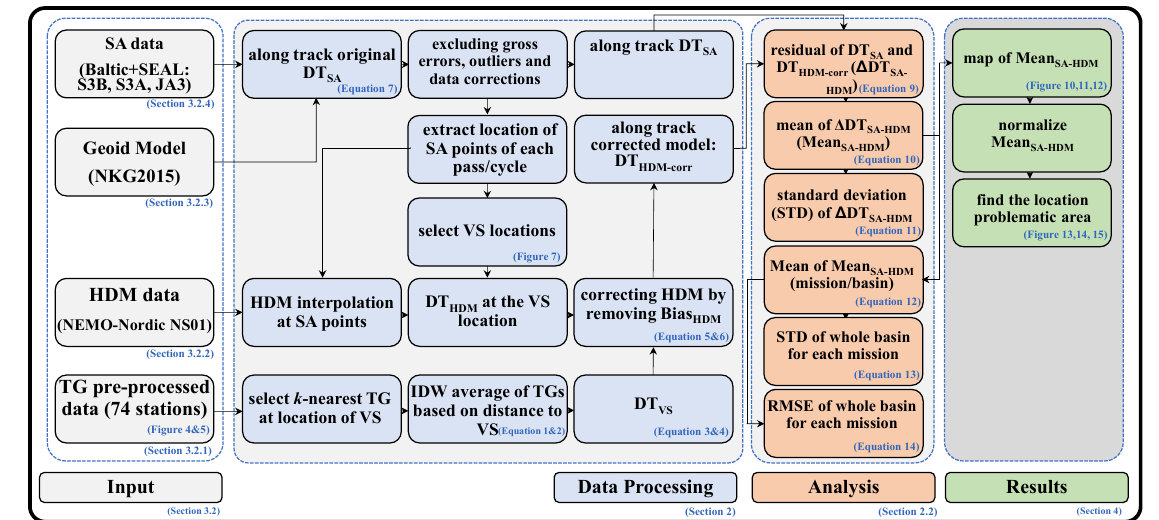
Figure 3. Work fl ow of di ff erent stages of developed methodology and analysis for validation and Figure 3. Workflow of different stages of developed methodology and analysis for validation and assessment process (the corresponding section, table, or fi gure of each stage is denoted by blue font). assessment process (the corresponding section, table, or figure of each stage is denoted by blue font). The used data products (in brackets) refer to the case study. The used data products (in brackets) refer to the case